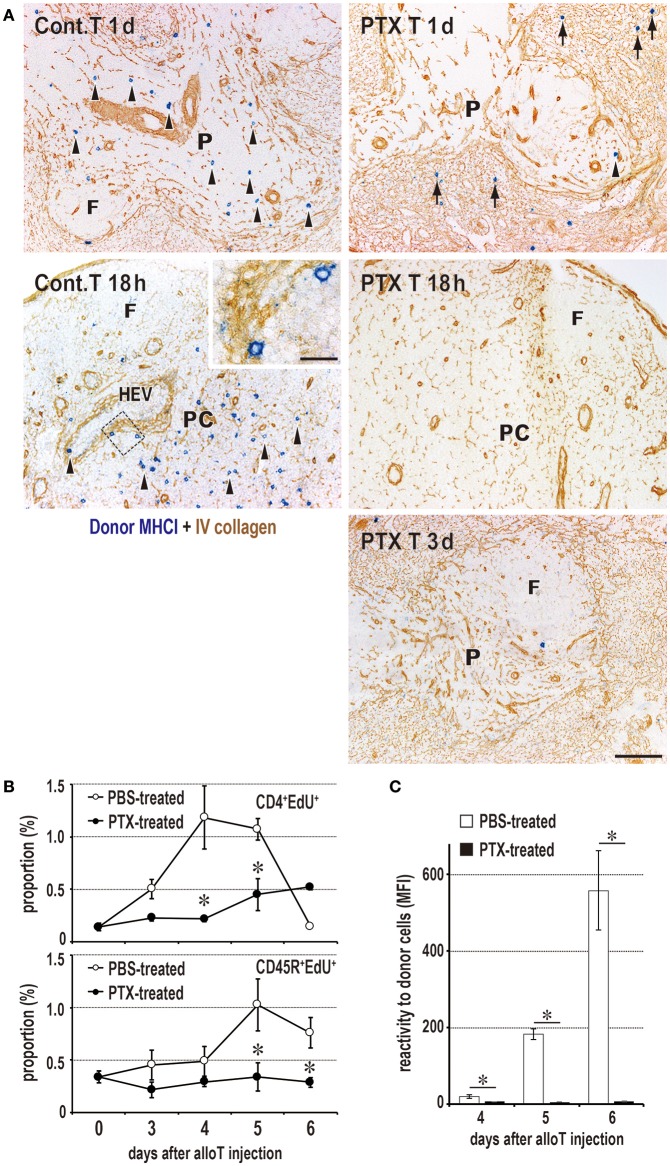
Requirement of T cell migration to the PALS for induction of the DST response. (A) Two-color immunostaining for donor MHCI (blue) and type IV collagen (brown) in the spleen at 1 and 3 days after 2 × 106 donor T cell injection and in the peripheral LNs at 18 h after 2 × 107 donor T cell injection. The control group exhibited migration to the PALS by 1 day (Cont T 1d, arrowheads) and LNs by 18 h (Cont T 18 h, arrowheads). In contrast, pertussis toxin (PTX) pretreated donor T cells did not enter the PALS up to 3 days (PTX T 3d), but stayed in the marginal zone and red pulp for 1 day (PTX T 1d, arrows). They did not enter the LNs (PTX T 18 h) either. F, lymph follicle; HEV, high endothelial venule; P, PALS; PC, paracortex. Scale bar = 100 μm or 20 μm (inset). (B,C) With PTX pretreatment of donor T cells, the DST responses of CD4+ T cells and CD45R+ B cells (B) and serum antibodies (C) were abrogated (mean ± SD, n = 3 rats each, *P < 0.05). MFI, mean fluorescent intensity.